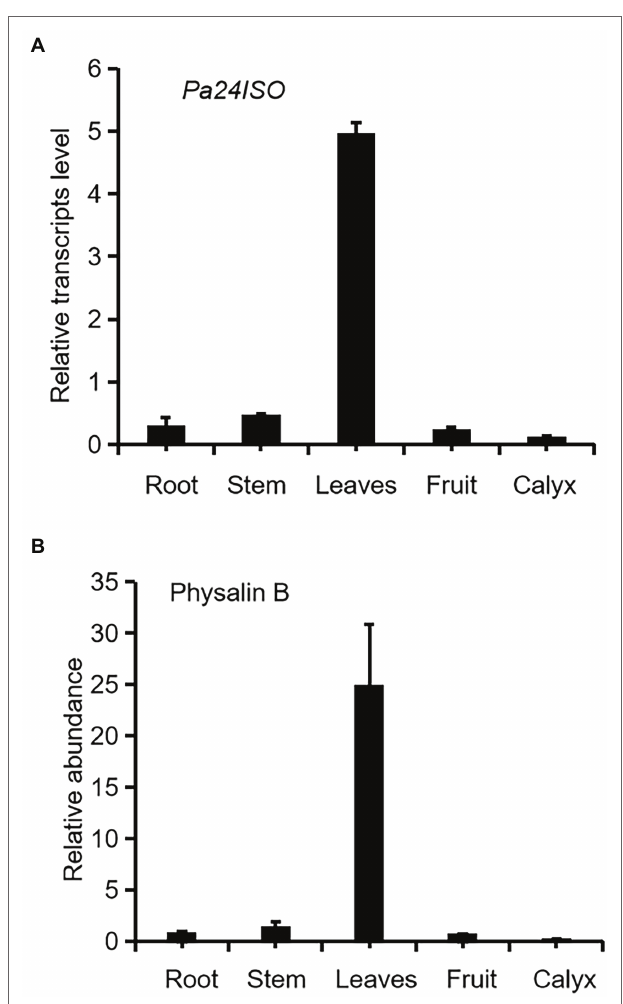
FIGURE 2 | Transcript abundance of Pa24ISO (A) correlates with the accumulation pattern of physalin B (B) in different tissues of P. angulata . The tissues, including root, stem, leaf (the fifth leaf materials from the top), fruit, and calyx, were collected from four and half-month old P. angulata plants for the analyses. At this stage, the calyx was in the size of about 0.7 cm of diameter. Means and standard errors are shown ( n =